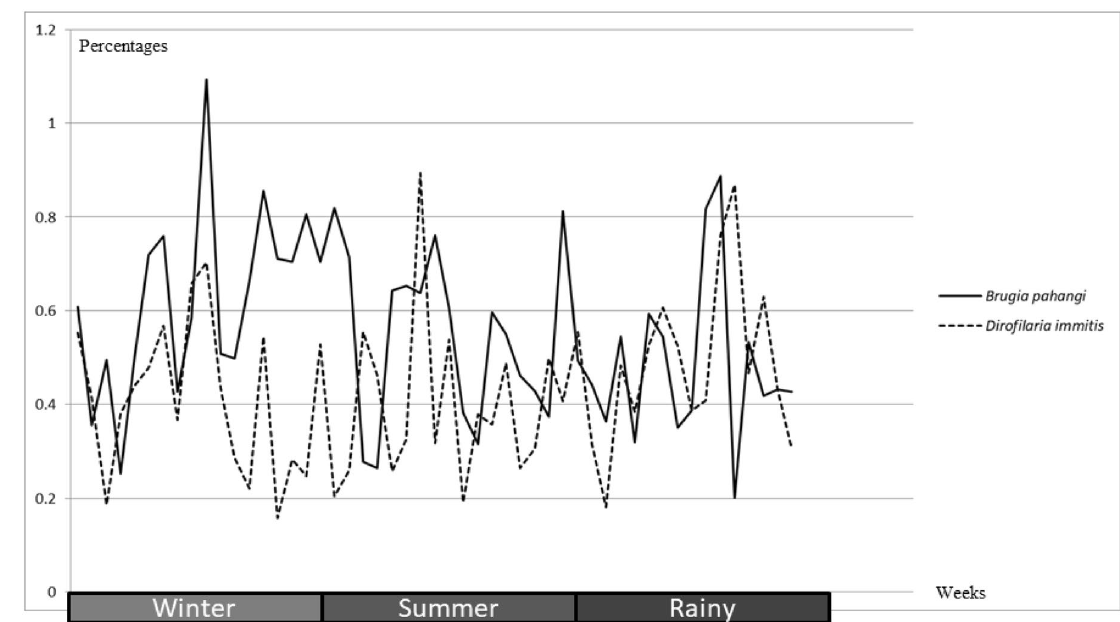
Figure 1. Line chart demonstrated positive rates of B. pahangi and D. immitis by seasons.